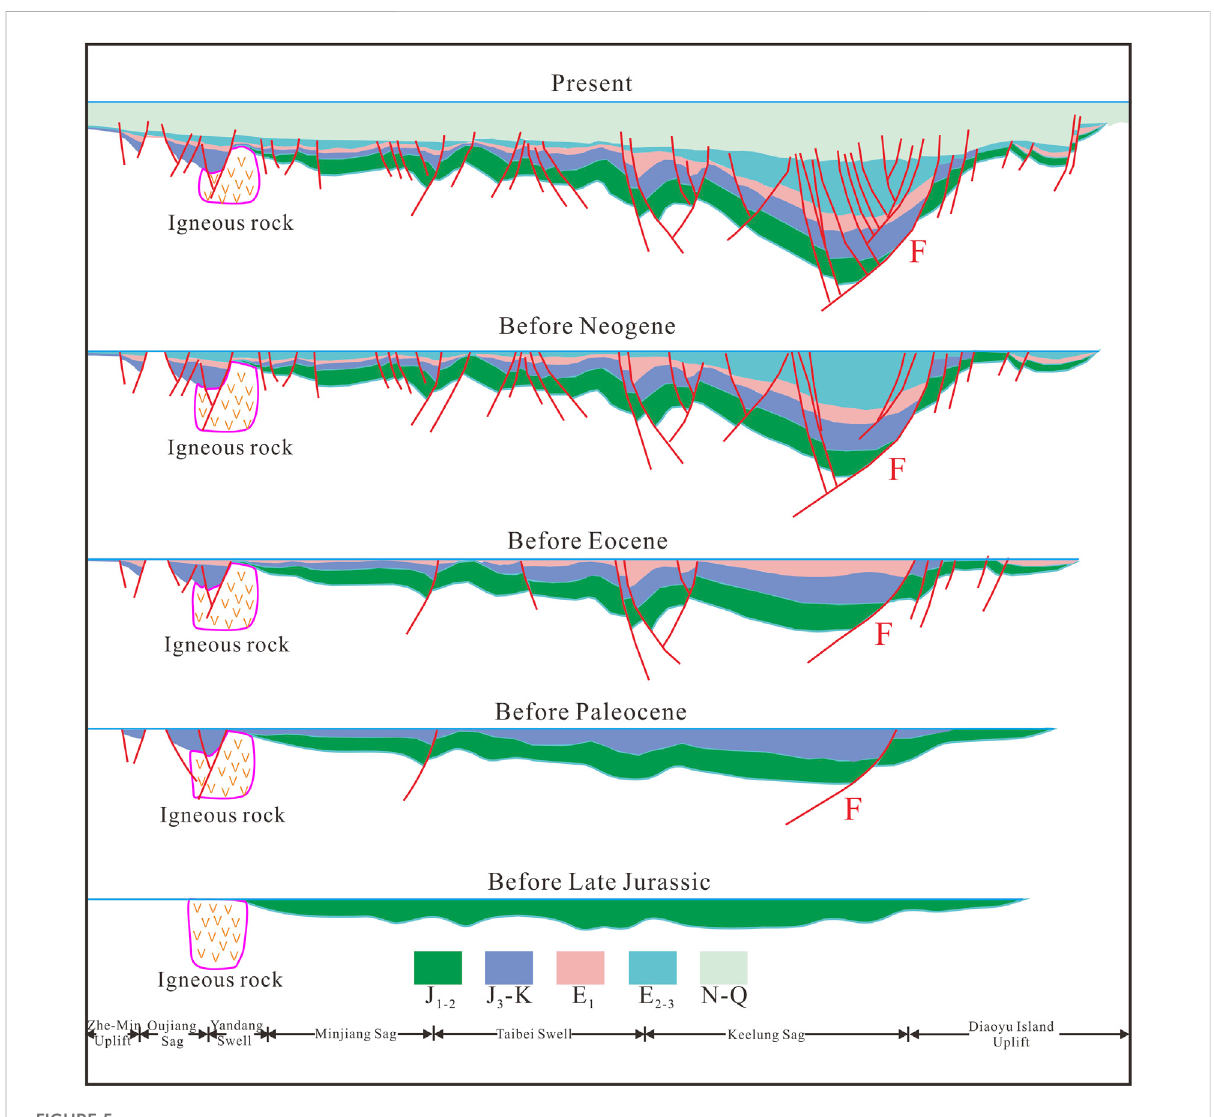
Tectonic evolution of SECS constructed from balanced section analysis in the southeast direction (F represents the western fault of Diaoyu Island in Figure 5). The J 1-2 label represents the Early – Middle Jurassic; J 3 -K represents the Late Jurassic – Cretaceous; E 1 represents the Paleocene; E 2-3 represents the Eocene – Oligocene; and N-Q represents the Neocene –